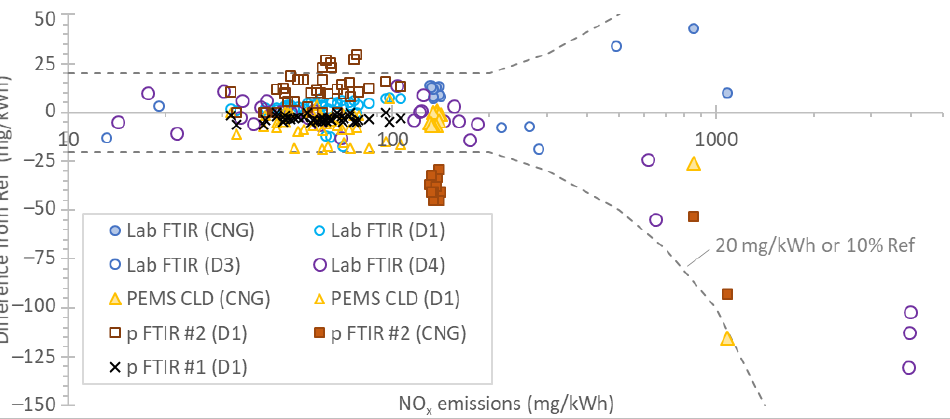
Figure 4. Differences of laboratory (Lab) or portable (p) FTIRs and the PEMS with respect to the laboratory real-time reference CLD analyzers. CLD = chemiluminescence detection; CNG = com- pressed natural gas engine; D = diesel engine; FTIR = Fourier transform infrared; p = portable; PEMS = portable emissions measurement system.